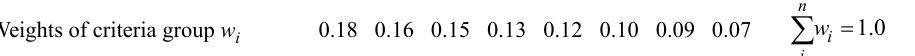
Table 9. The results of weight calculation of the criteria describing the research object Criteria group Total The relationship between the main (twelfth) criterion with other +1 +2 +3 system’s criteria Weights of criteria group w i